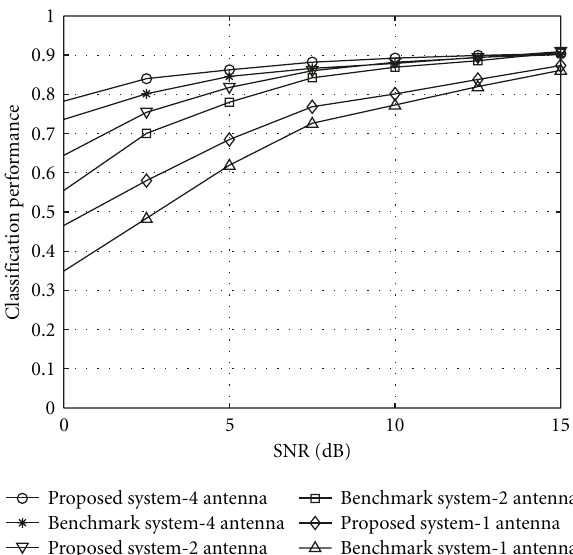
Figure 11: Final classification performance of proposed classifier and benchmark in a slow flat fading channel using MRC.